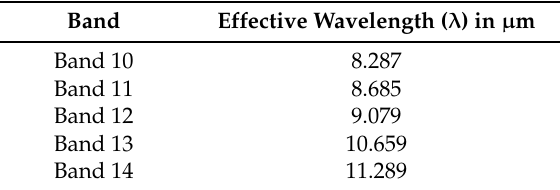
Table 7. Effective wavelengths of the TIR channels of the ASTER